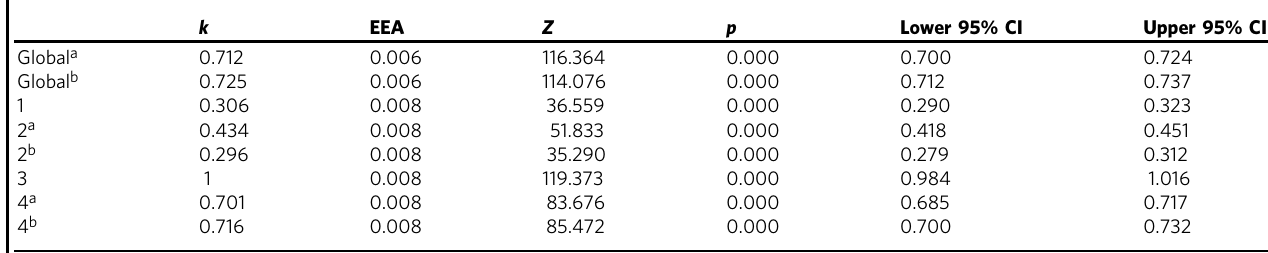
Table 5 Fleiss ’ kappa coef fi cient.